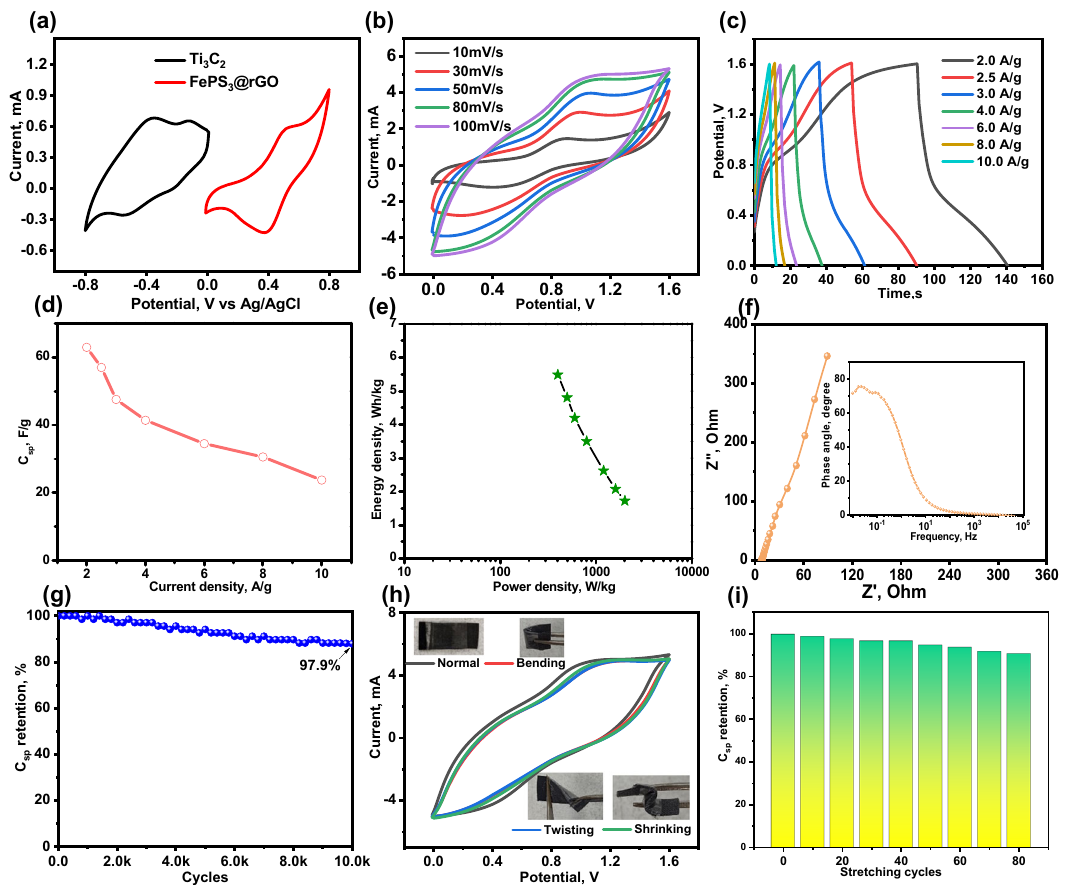
Fig. 4 Electrochemical performance of Ti 3 C 2 /FePS 3 @rGO SASC. a CV curves of Ti 3 C 2 and FePS 3 at scan rate 50 mV s − 1 . b CV curves of Ti 3 C 2 / FePS 3 @rGO SASC at different scan rates. c GCD plots as function of current densities. d C sp at different current densities. e Ragone plot: power density versus energy density. f Nyquist plot (inset display bode plot). g Long-term cycling stability. h CV curves of the device measured at various bending modes. i C sp retention versus 30% stretching over 80